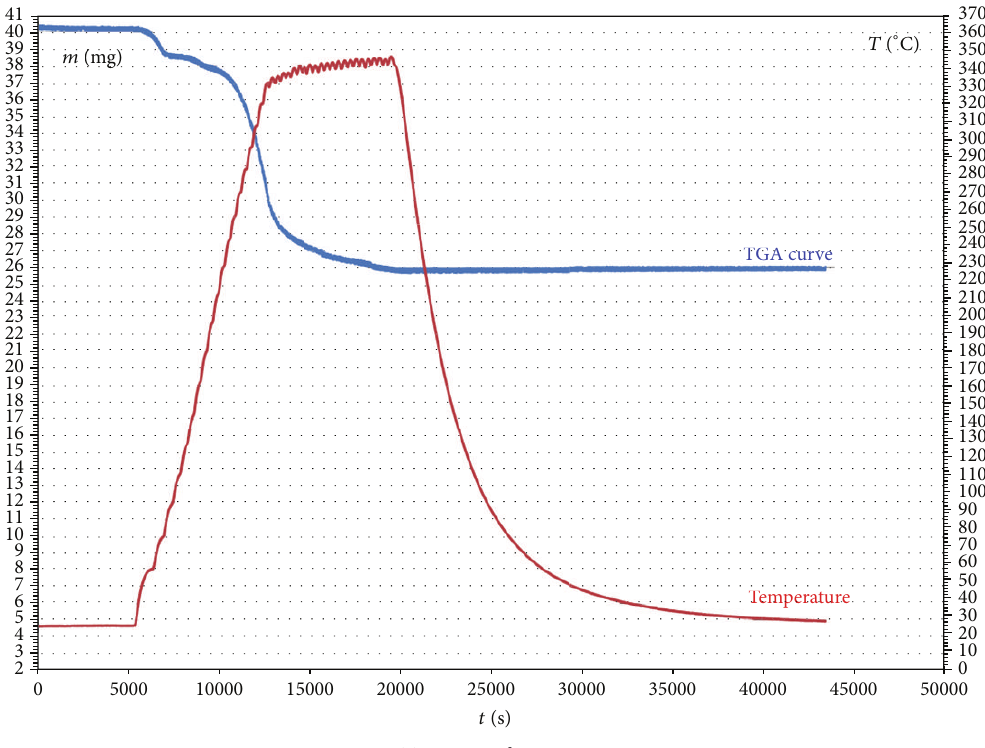
Figure 9: TG curve of 2C 13 H 12 N 2 O ⋅ H 2